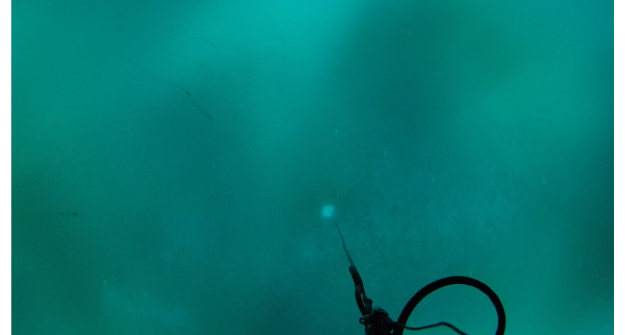
Figure B1. Video frame (00:58) from GoPro Hero 4 recording of C- OPS descent from 0 to 30m, 18 May 2015 at the “low snow” hole. Note the streaks of nekton swimming across the upper left quadrant of the frame. Many plankton were seen in this profile, indicating an active under-ice community. A profile of the “high snow” hole on the same day, just 40m away, showed no such plankton activity.